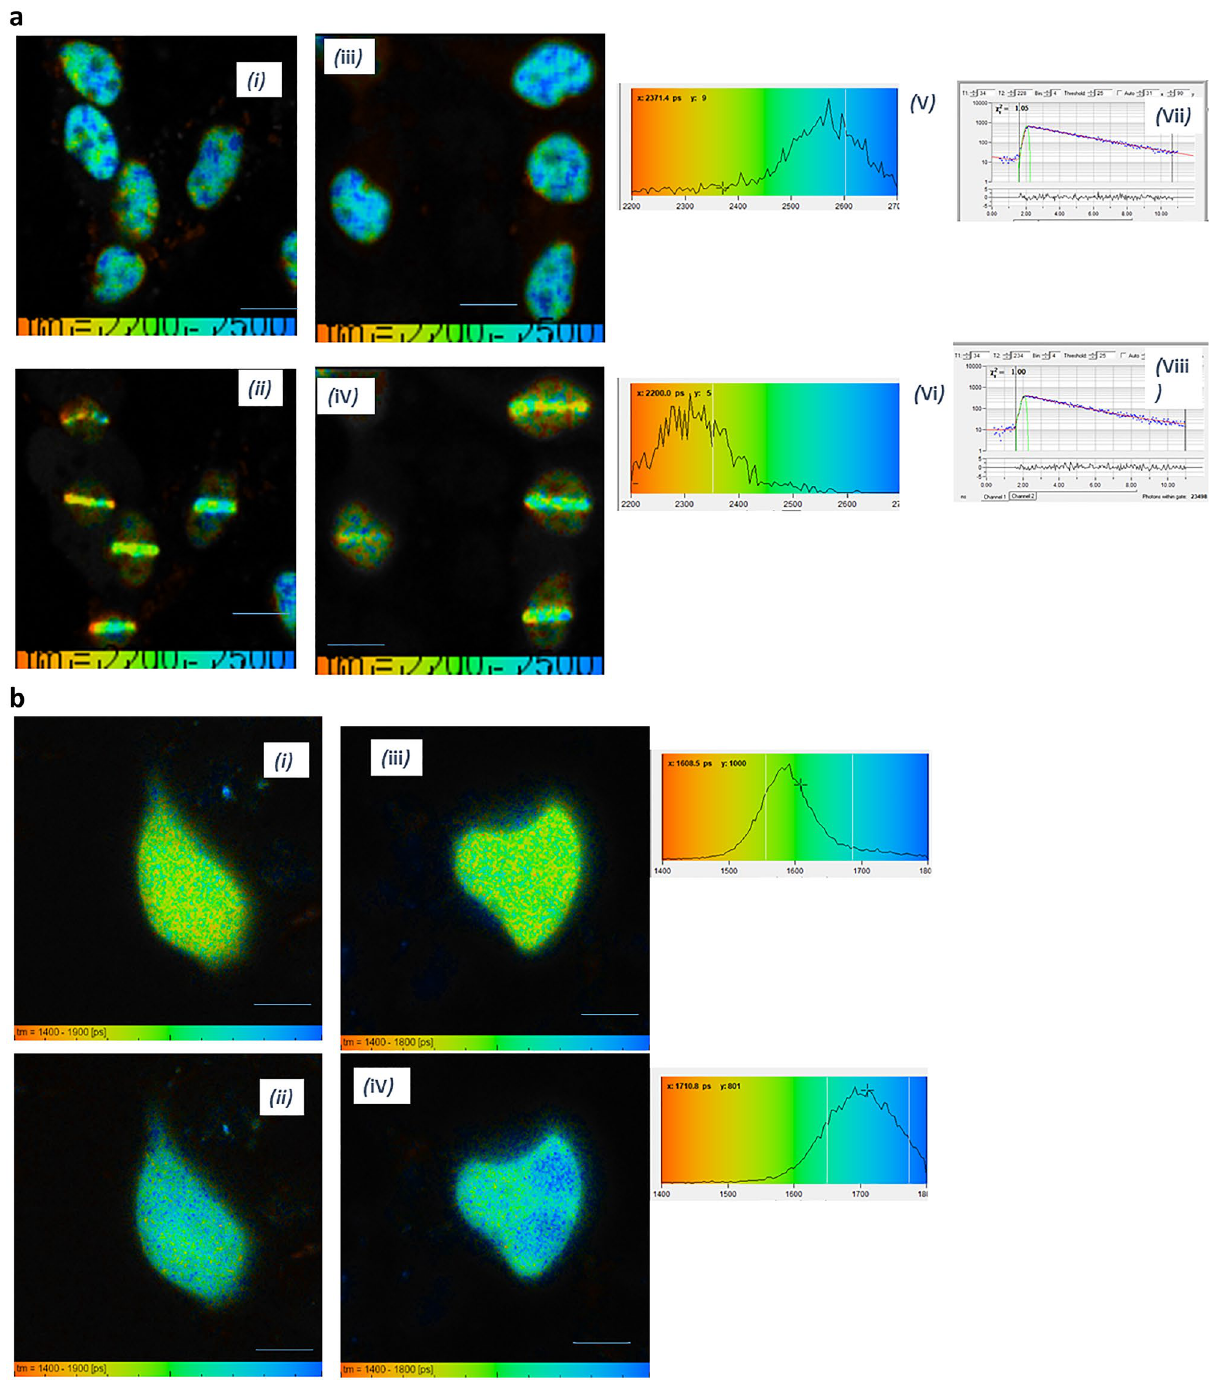
Figure 5. ( a ) Viscosity change in V15B mammalian cells expressing DNA repair protein GFP-Ku80. FLIM of cells before laser microbeam irradiation (i and iii). FLIM after microwatt (~ 1 µW average power) irradiation (ii and iv). Histograms for i and ii (v and vi) shows the shift in GFP lifetime indicating significant viscosity change. vii and viii typical decays. Scale bar 10 µm. ( b ) Viscosity change in CHO mammalian cells expressing non- specific mCherry fluorescent protein. FLIM of cells before laser microbeam ~ 1 µW irradiation (i and iii). FLIM after microwatts irradiation (ii and iv). Histograms shows the shift in mCherry lifetime indicating significant viscosity change. Scale bar 10